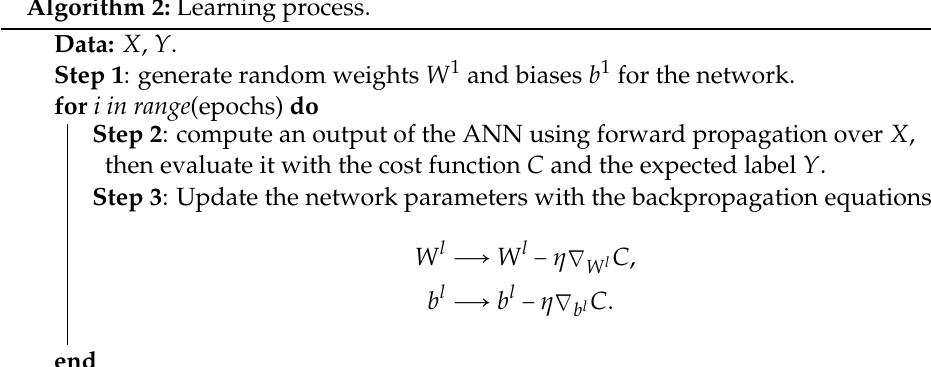
Algorithm 2: Learning